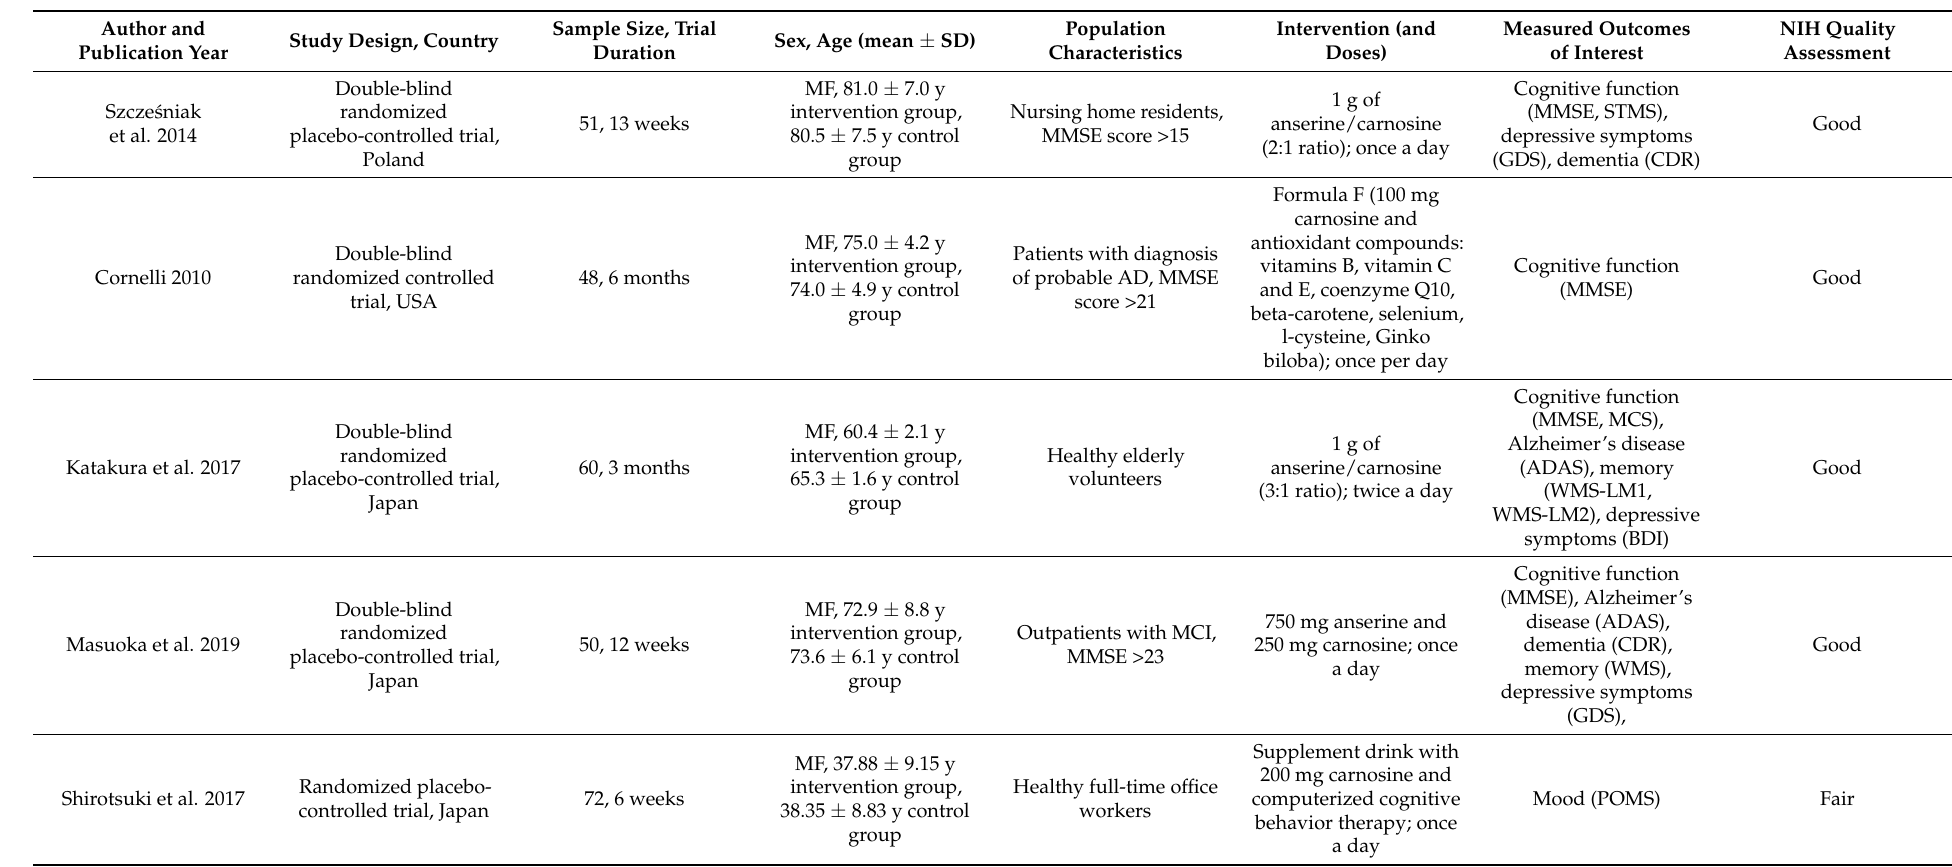
Table 2. Main characteristics of the studies included in the systematic review and